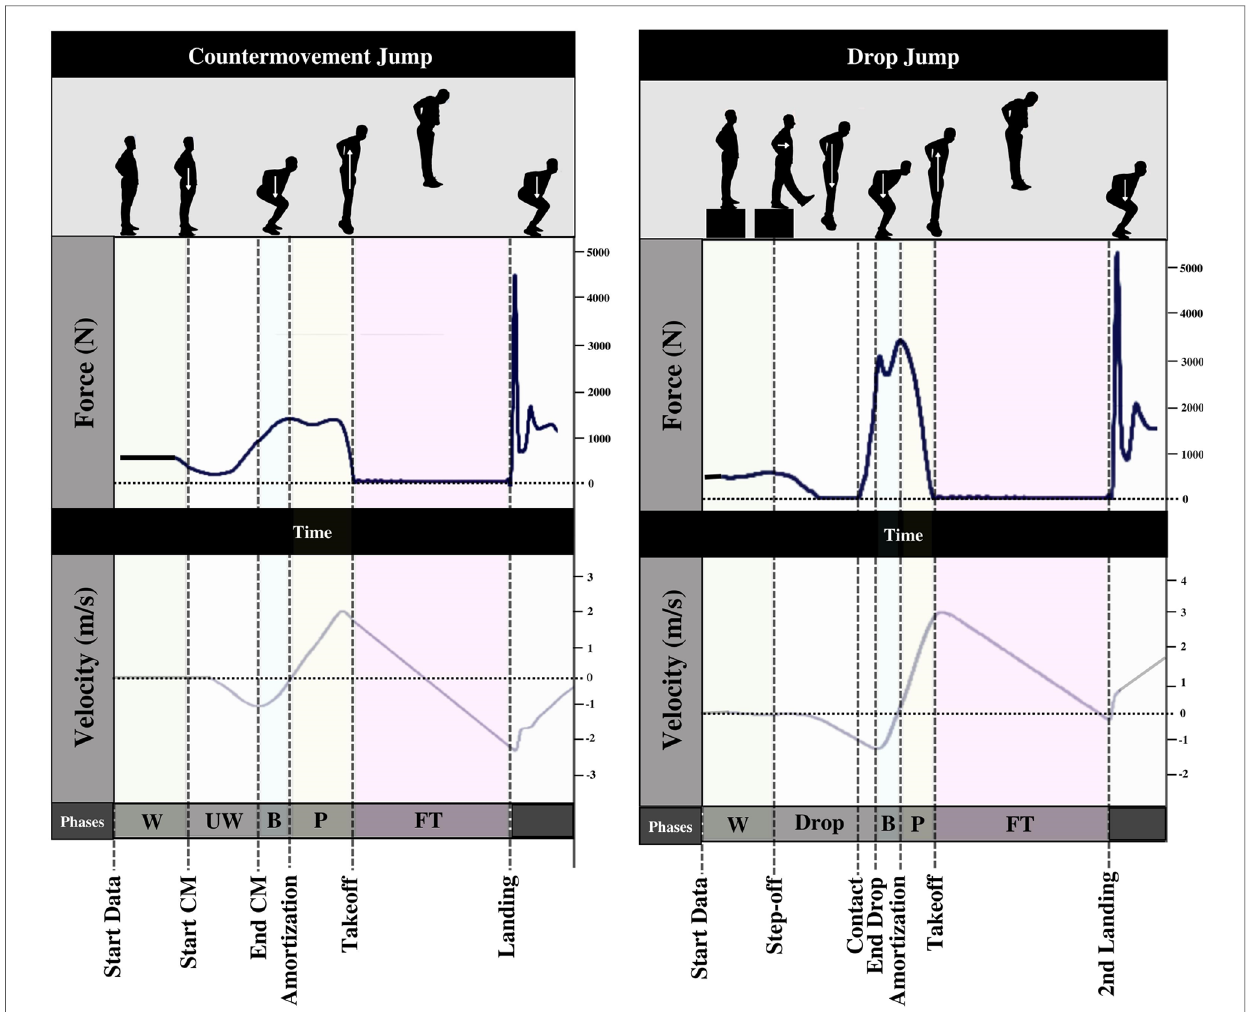
FIGURE 3 Phase detection of countermovement jump and drop vertical jump. CM, countermovement; W, weighting phase, UW, unweighting phase; B, braking phase; P , propulsive phase; FT, fl ight